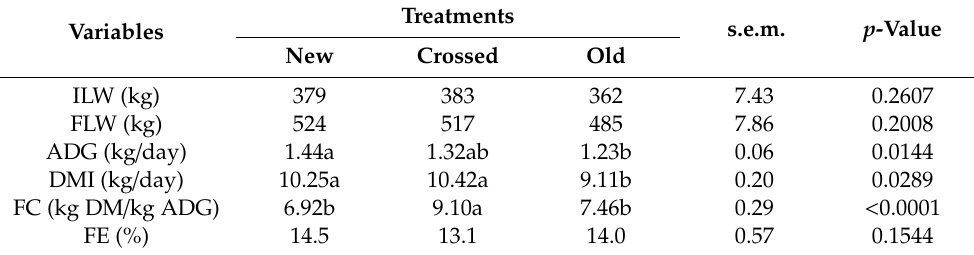
Table 5. Performance and e ffi ciency of Canchim steers from di ff erent lines finished in feedlot.